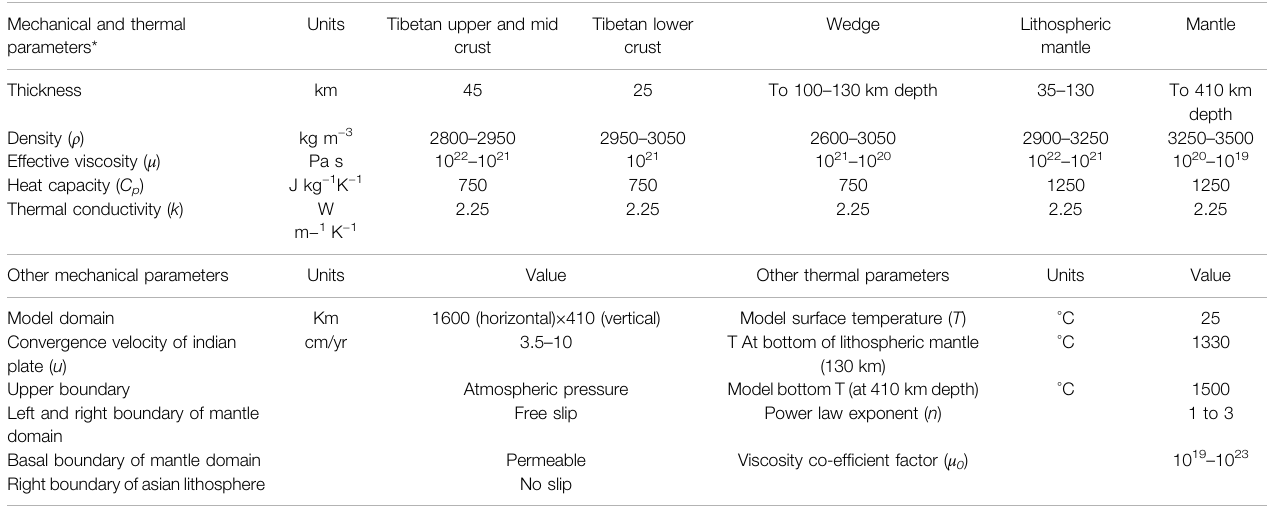
TABLE 1 | Parameters used in models. Mechanical and thermal